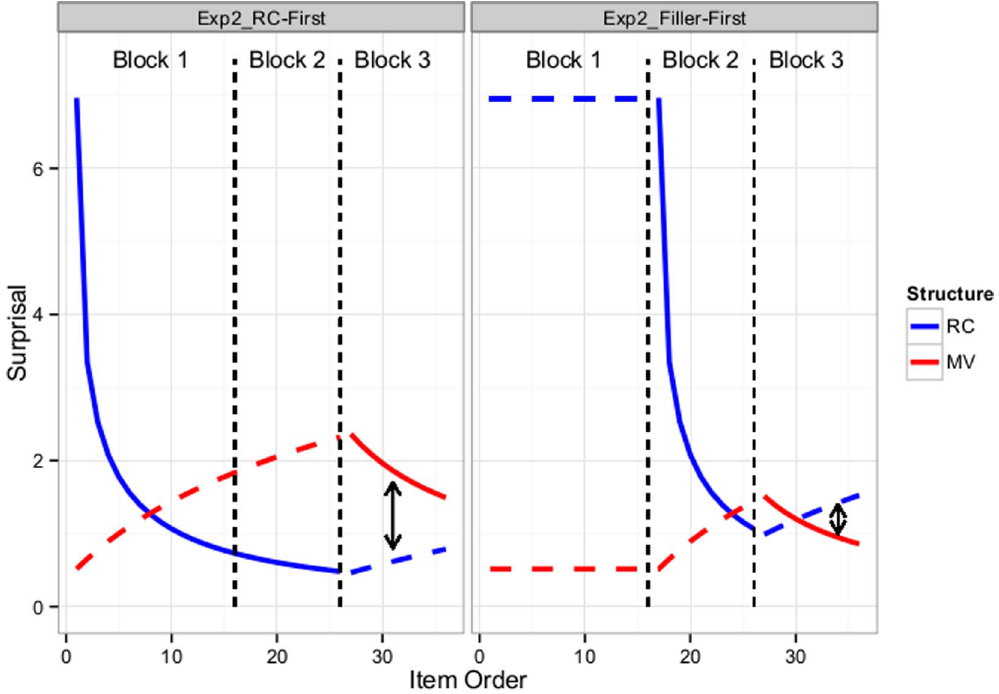
Figure 6. Predicted changes in surprisal for Experiment 2. Predicted changes in surprisal for the RC-First (left panel) and Filler-First (right panel) groups for both RCs (blue) and MVs (red). Dashed lines indicate predicted changes in surprisal of structures not present in a given block (e.g., the surprisal of MVs is predicted to change throughout Blocks 1 and 2 as a result of the occurrence of RCs, but no MVs actually occur in those blocks). Black arrows indicate the average predicted surprisal of MVs relative to RCs during Block